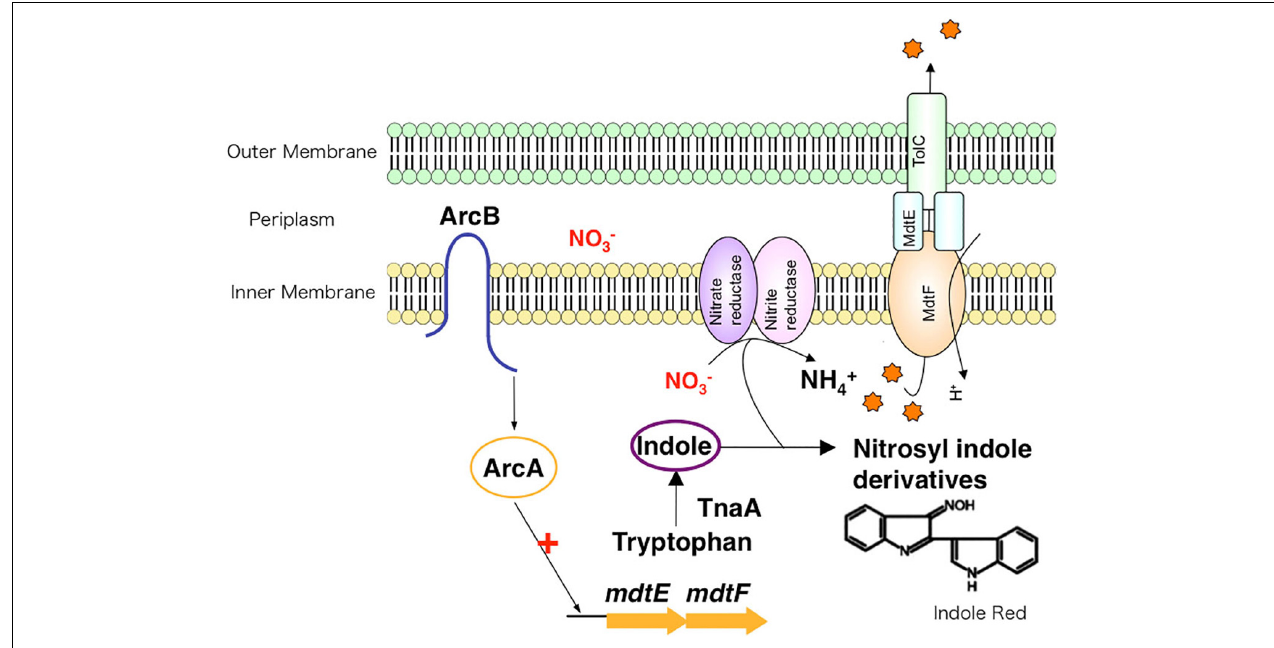
FIGURE 5 | The role of drug efflux pumps in anaerobic environments. Under anaerobic conditions, nitrate respiration results in toxic compounds, such as indole red, inside of bacteria. To protect the cell from these toxins, drug efflux systems extrude toxic compounds to the outside of the cell.